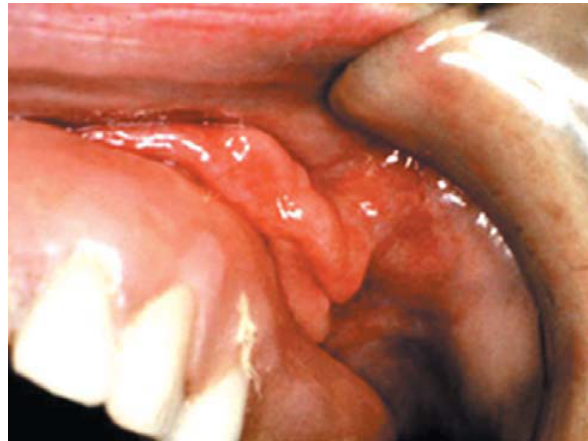
FIGURE 4- Epulis